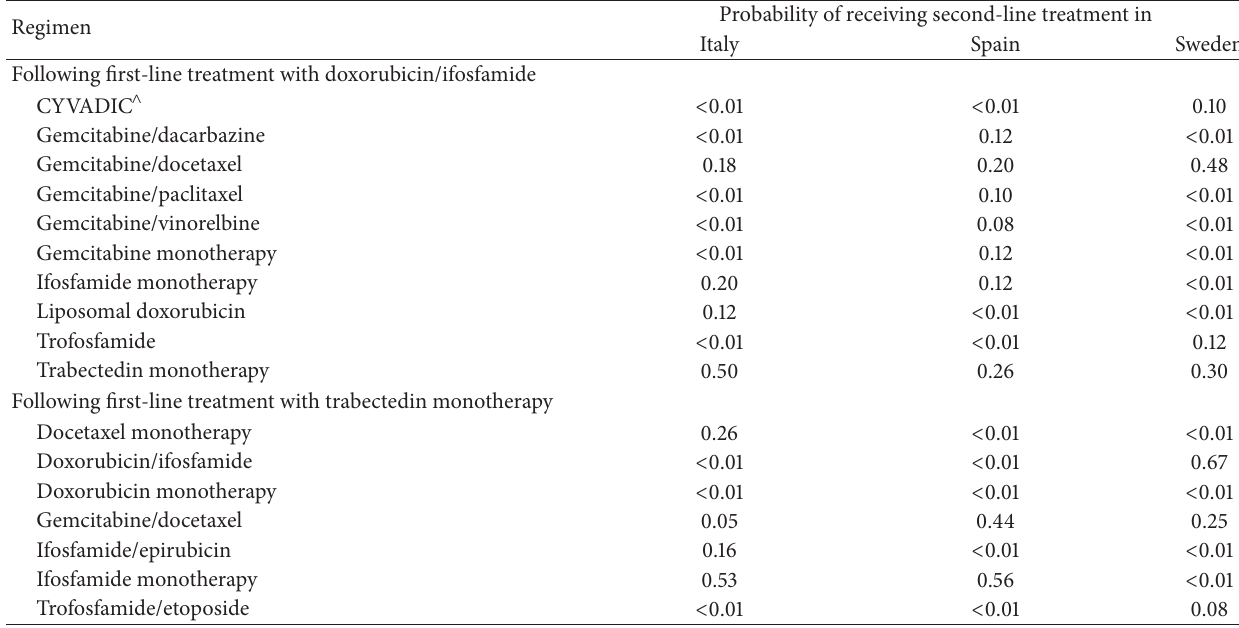
Table 1: Probabilities of receiving second-line treatments.